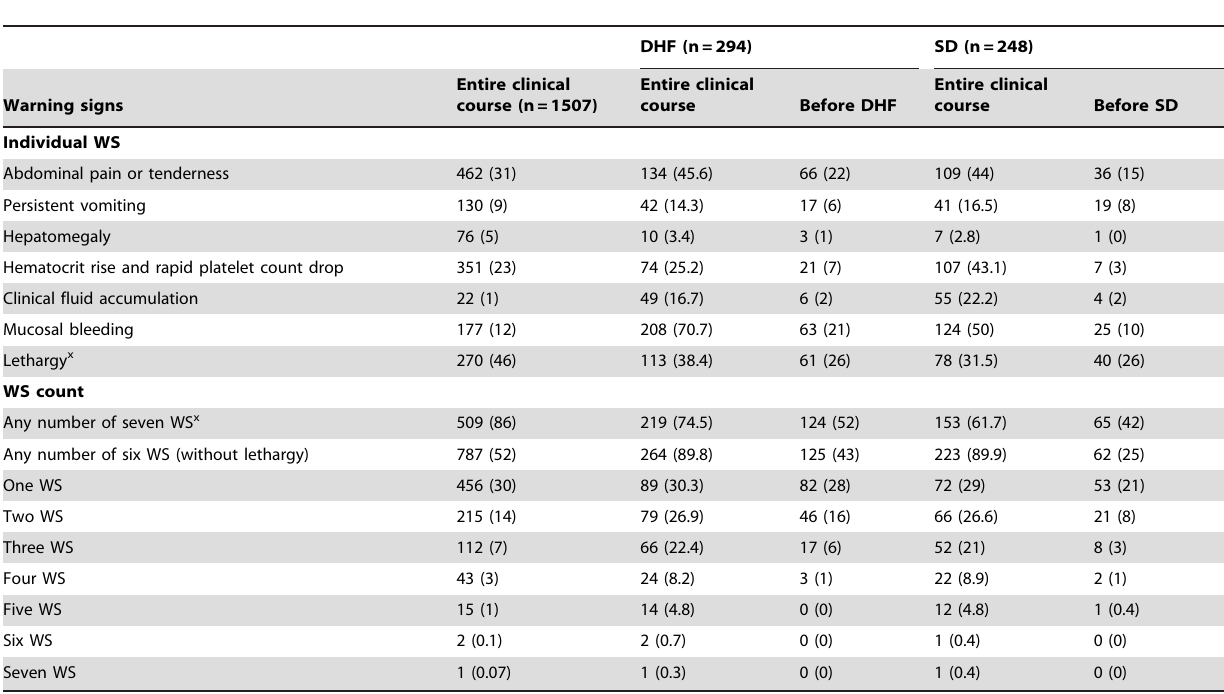
Table 2. Prevalence of warning signs (WS) during the entire clinical course, and before the development of dengue hemorrhagic fever (DHF) and severe dengue